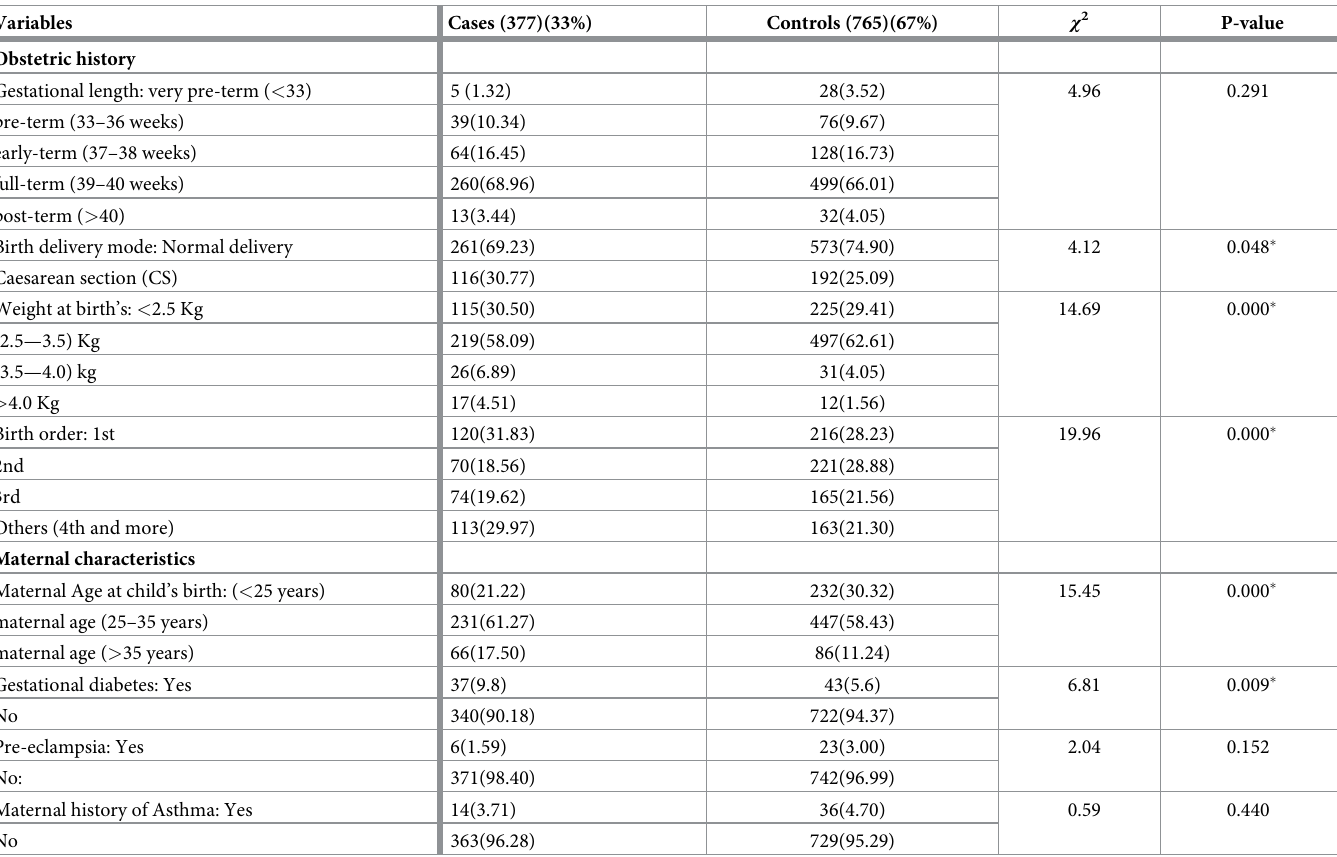
Table 2. Characteristics of the study cohort for obstetric history and maternal characteristics together with their corresponding frequency count and percentage for case and control groups. The hypothesis test results from a chi-square test of homogeneity in the distribution of categorical variables between the two groups together with their corresponding p-value are also presented. The significance level was set at α = 0.05, with statistically significant differences highlighted with an asterisk ( �